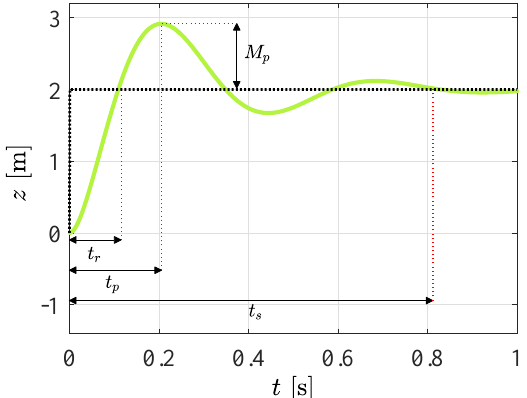
Figure 11. Time response of a closed-loop controlled second order dynamical